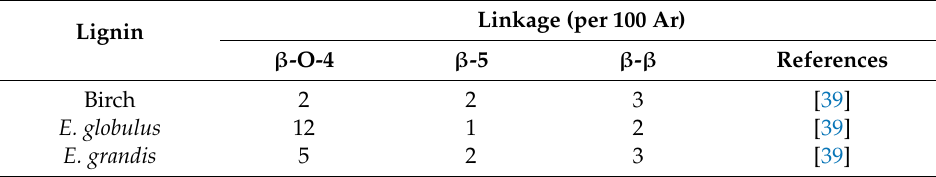
Table 2. Frequency of lignin linkages in hardwood kraft